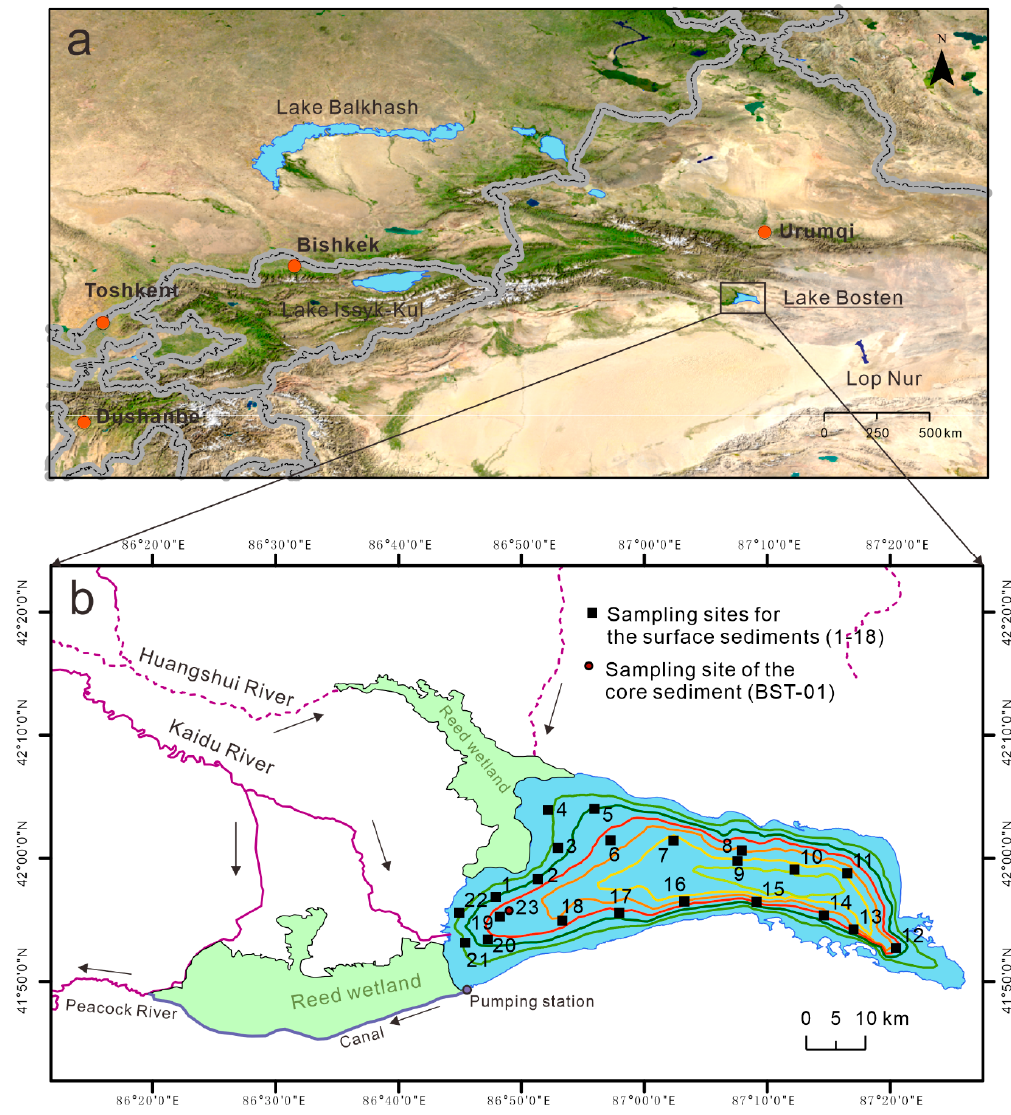
Figure 1. Location map of Bosten Lake ( a ) and sampling points ( b ).